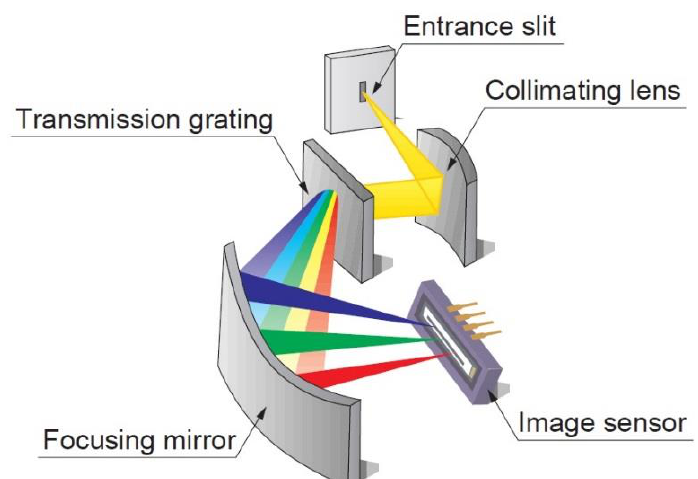
Figure 1. Schematic of a Hamamatsu C10082CA miniaturized spectrometer [1].